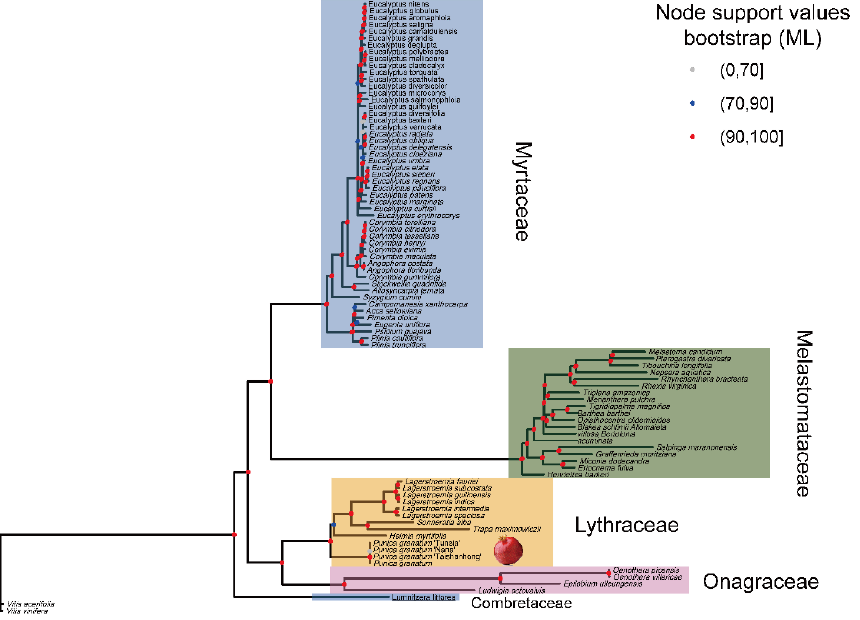
Figure 6. Phylogenetic tree was reconstructed using Maximum likelihood (ML) and Bayes inference (BI) methods based on complete cp genomes of the order Myrtales. Only the tree topology of the ML tree was presented.